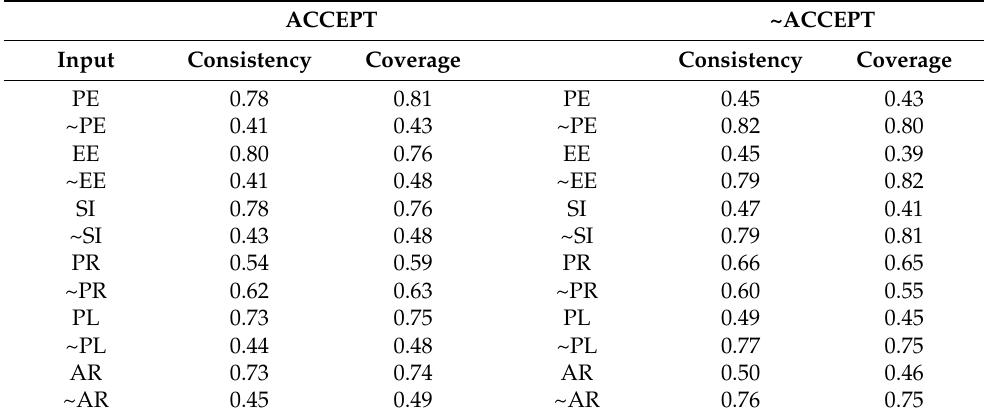
Table 4. Necessity analysis of the income variables on ACCEPT and